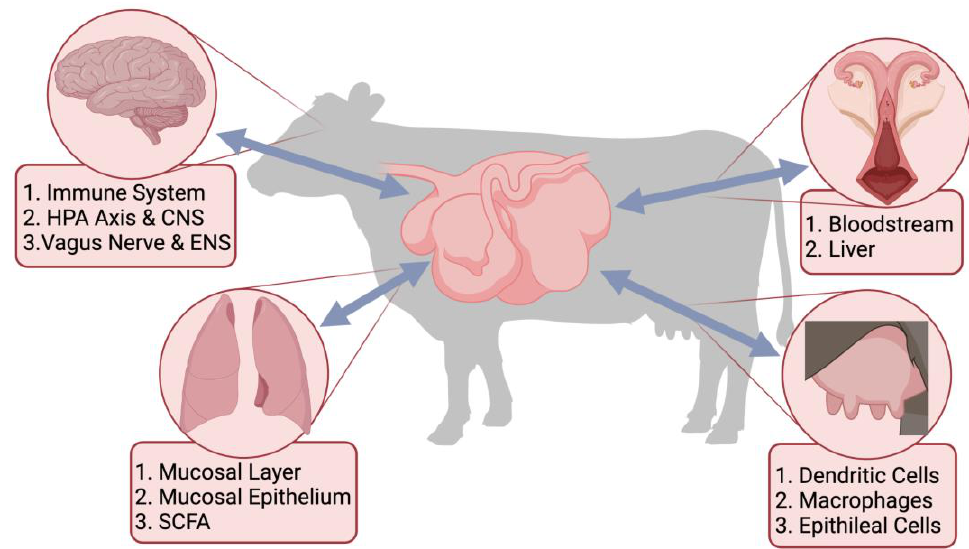
Figure 1. Proposed links between the gastrointestinal tract microbiota and different organ systems through the microbiome-gut-organ axes, including the microbiome-gut-brain axis (MGOA), the microbiome-gut-lung axis, the microbiome-gut-reproductive axis, and the microbiome-gut-mammary axis. Included are pathways, cells, and metabolites important for the bi-directional communication of the MGOA.